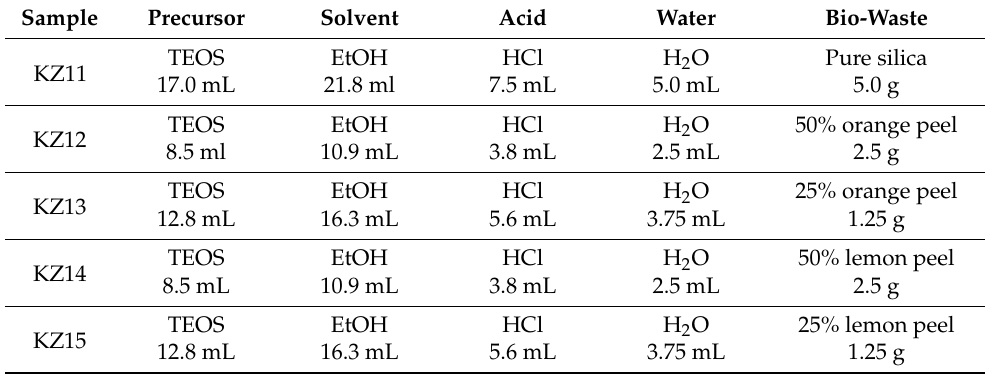
Table 3. Conditions employed in silica synthesis using hydrochloric acid as a